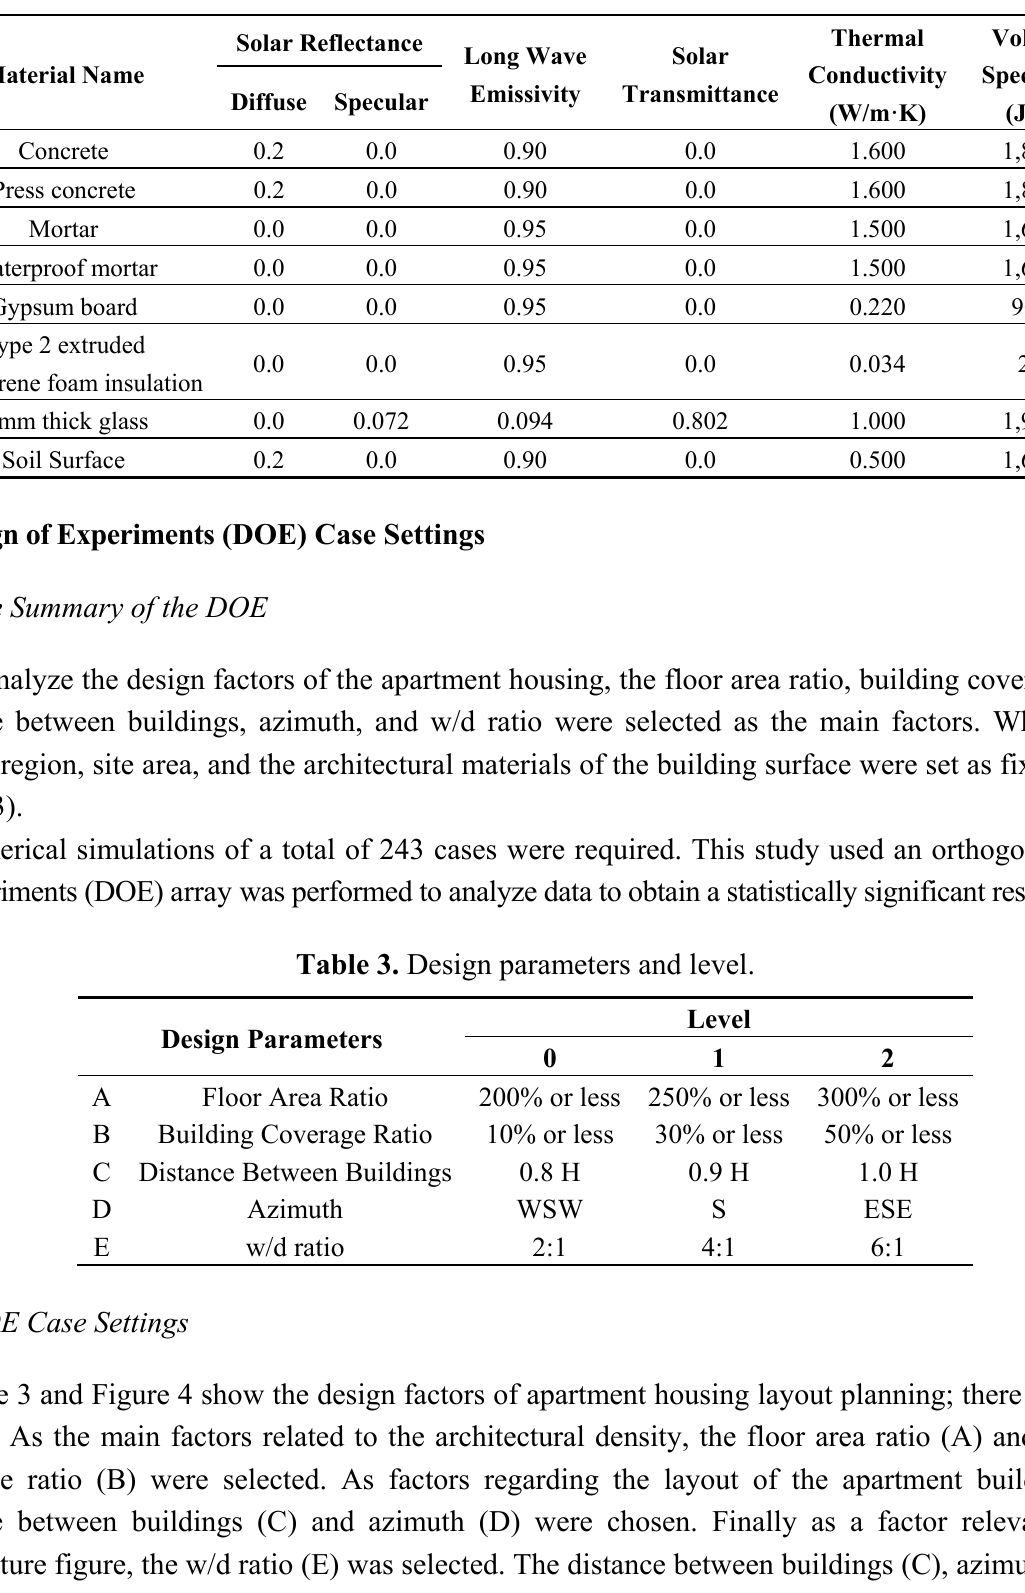
Table 2. Properties of the materials of which the housing block was composed.